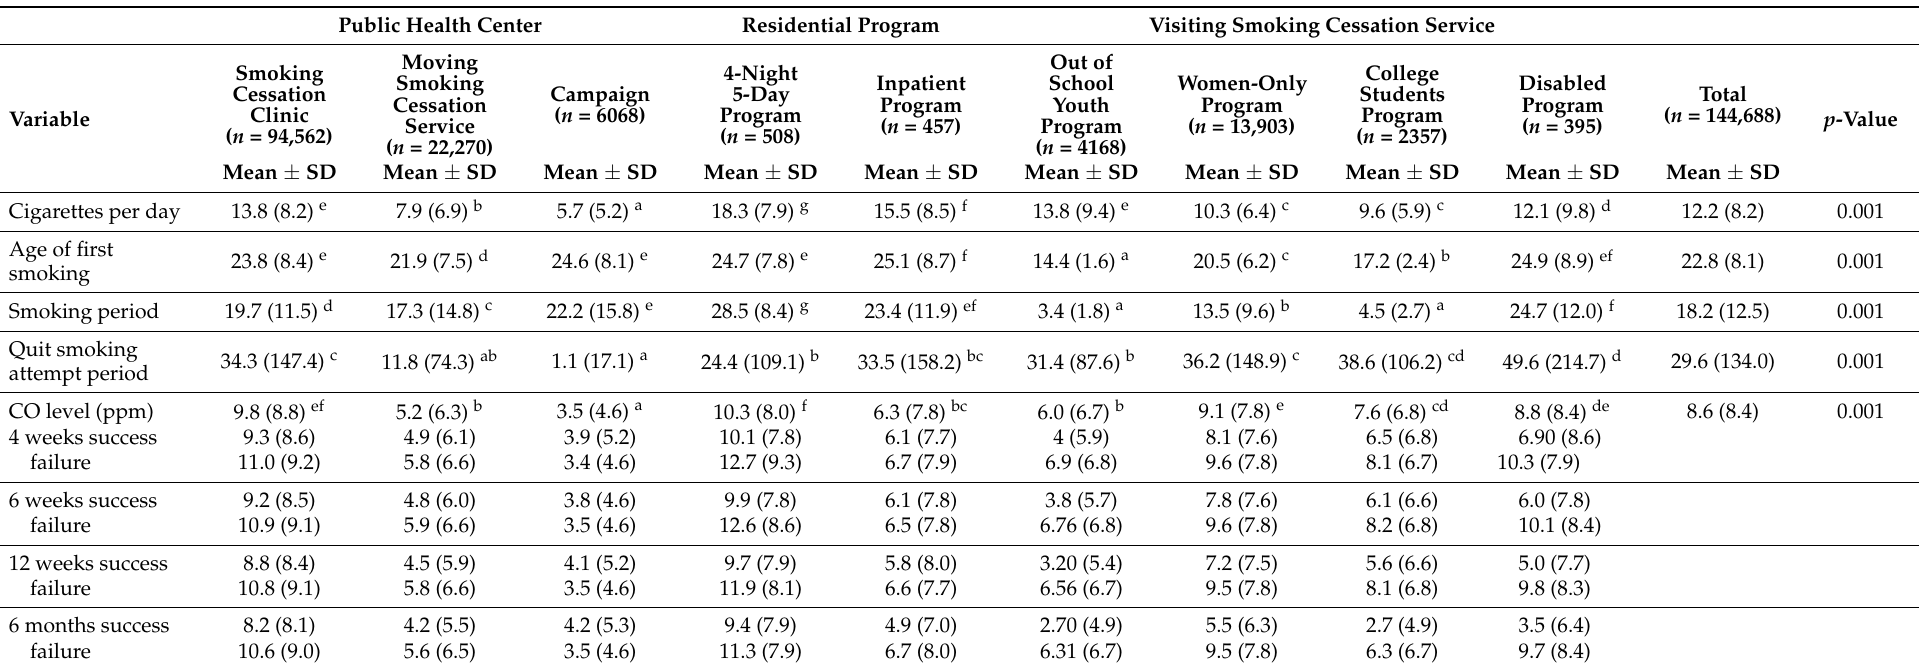
Table 2. Smoking-related characteristics of study